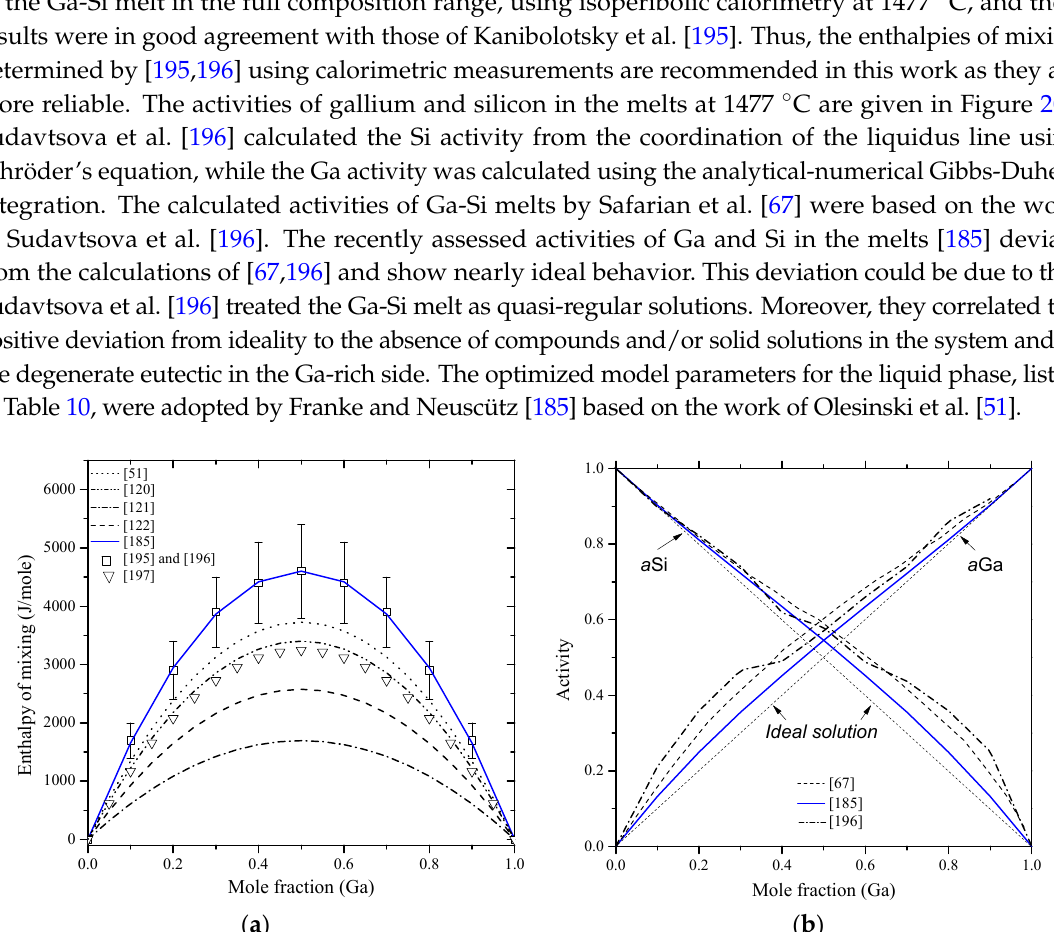
Figure 20. ( a ) Enthalpy of mixing of the Ga-Si liquid at 1477 °C; ― : [185]; □ : [195] and [196] at 1487 ± 5 °C; - · - · - : [121]; - ·· - ·· - : [120]; -----: [122]; : [197]; ···· : [51] at >1414 °C and ( b ) Activity of gallium and silicon in the Ga-Si liquid; ― : [185]; -·-·-: [196] and ------ : [67] at 1477 °C. Table 10. Optimized model parameters of the Ga-Si system. Phase Excess Gibbs Energy Parameter (J/Mole) Ref.